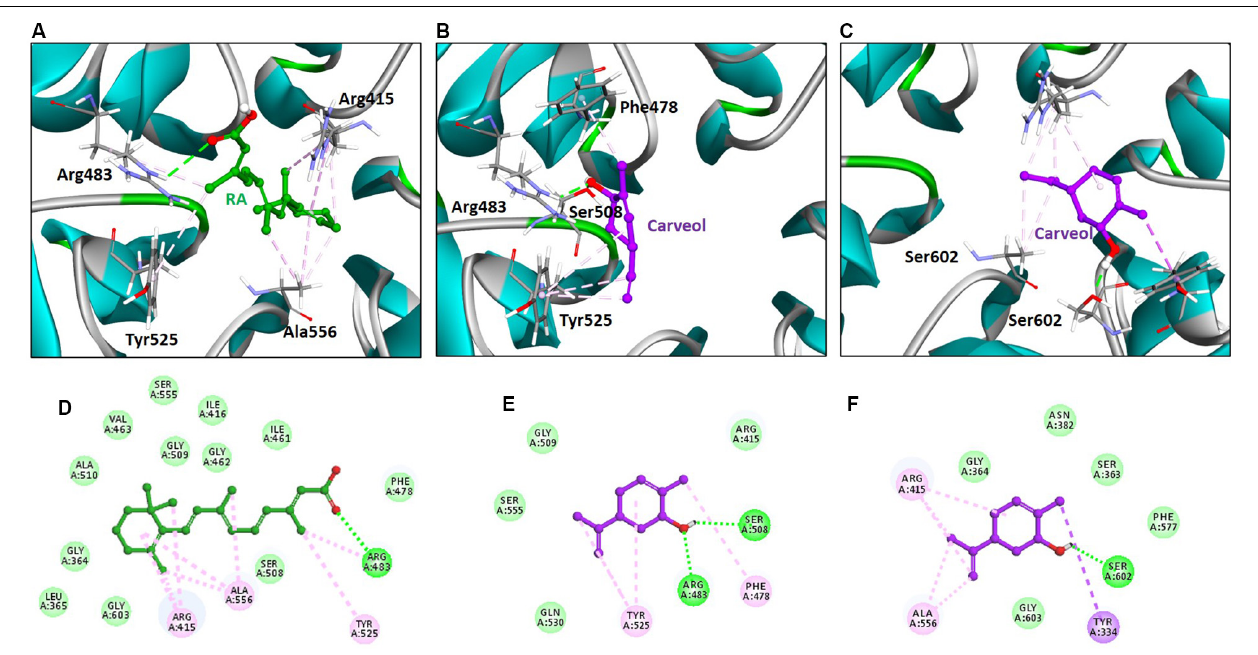
FIGURE 9 | Retinoic acid and carveol occupy the Nrf2-binding site of Keap1. The upper panel (A–C) shows the binding orientation of retinoic acid and carveol in the Nrf2-binding site of Keap1. (A) Retinoic acid established hydrogen bond with Arg483 of Keap1. (B) One carveol molecule formed a hydrogen bond with Arg83 and Ser508 in the acidic region of Keap1. (C) Another carveol molecule established a hydrogen bond with Ser602 in the sulfamide region of Keap1. Retinoic acid and carveol are represented as ball and stick models and colored as green and magenta, respectively. Keap1 residues participated in either polar or non-polar interactions are depicted as stick representation. Hydrogen bonds are represented as green color dashed lines. Other hydrophobic interactions are portrayed as light magenta-colored dash lines. Lower panel (D–F) displayed the 2D (two dimensional) interaction pattern of Retinoic acid and carveol with Keap1. (D) Retinoic acid, (E) carveol in the acidic region of Keap1, and (F) carveol in the sulfamide region of Keap1 formed hydrogen bonds with Keap1. Retinoic acid and carveol are presented as ball and stick models and colored as green and magenta, respectively. Hydrogen bonds forming residues are represented as green color circles and labeled. Hydrogen bonds are displayed as green-colored dash lines. Other non-polar interacting residues are depicted as light green colored (residues forming Van der Waals interactions) and light magenta-colored (hydrophobic interactions) and